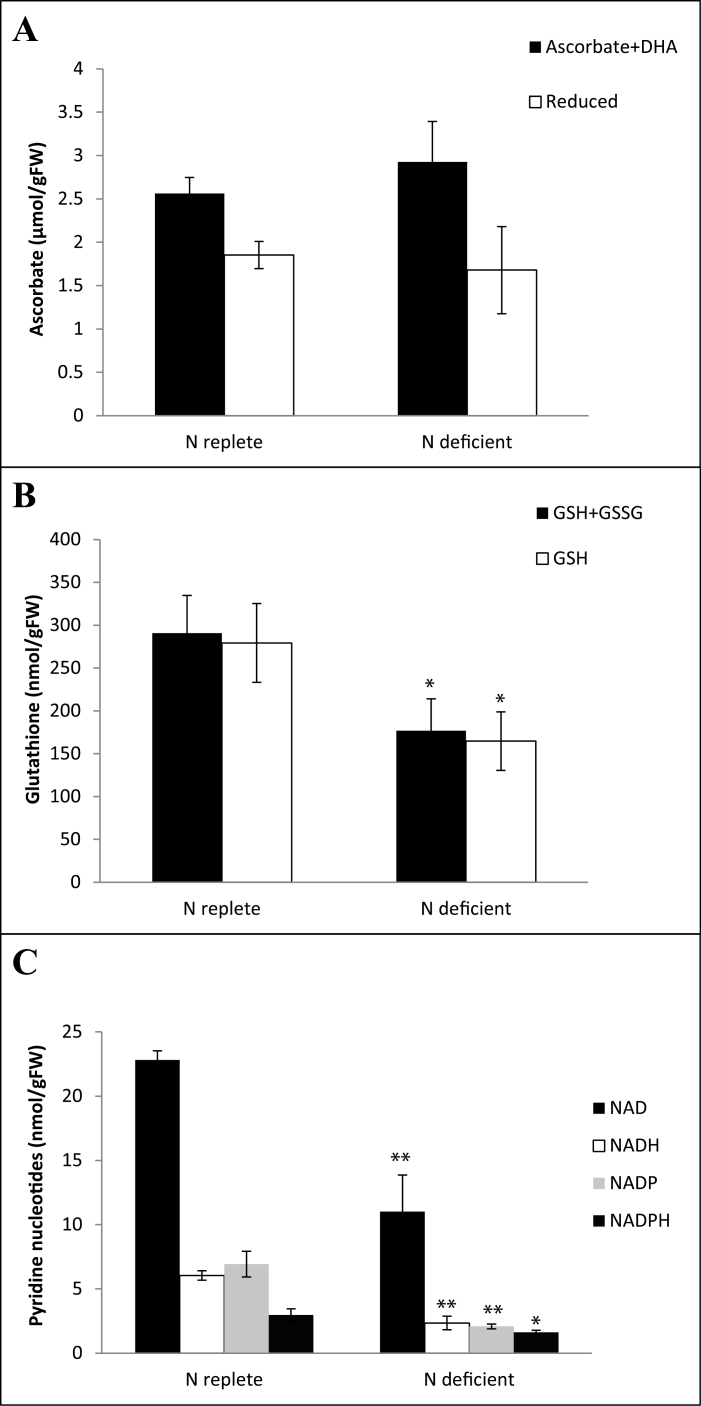
Impact of N availability on shoot redox couples. Plants were grown under N repletion or N deficiency as described in the text and harvested 7 d after transfer to variable N conditions. Total and reduced ascorbate (A), glutathione (B) and oxidized and reduced pyridine nucleotides (C) were estimated according to Queval and Noctor (2007). Data is represented according to the figure legends as mean values ±SE (n=4) and significant differences between plants grown under N repletion or N deficiency as estimated by the Students t-test are indicated; * P<0.05, ** P<0.01.